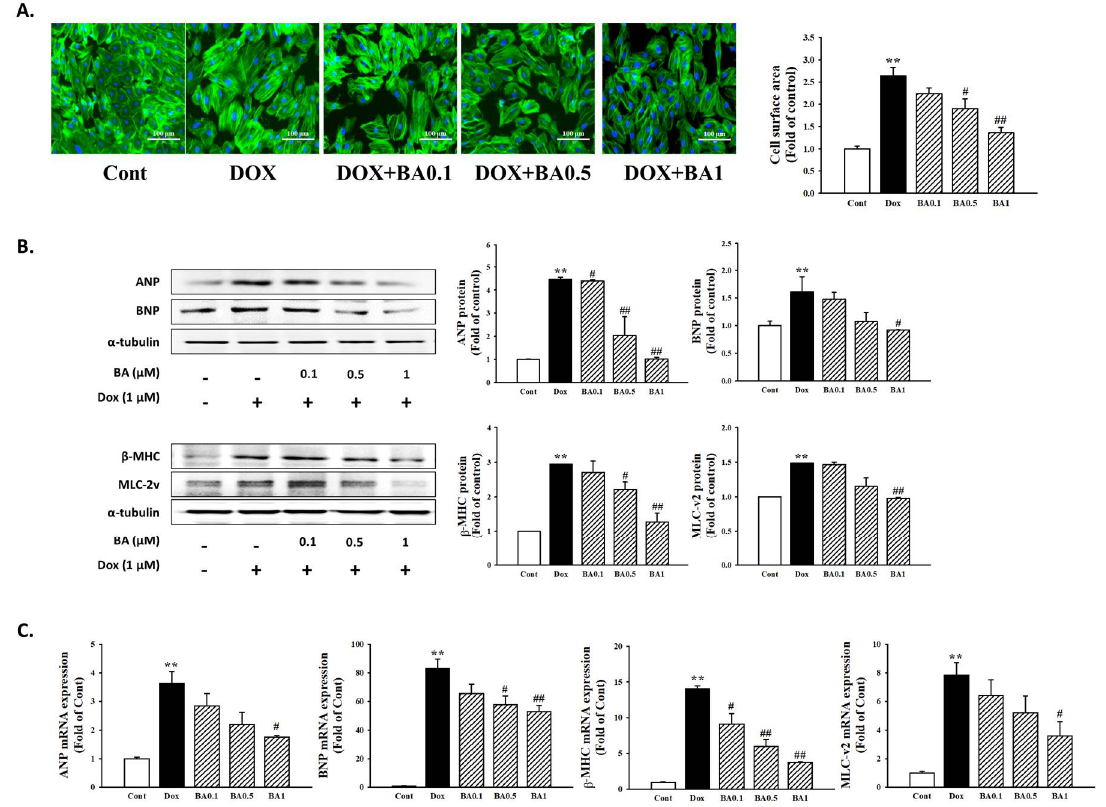
Figure 2. The effects of BA on DOX-induced cardiac hypertrophy. ( A ) The effects of BA on cell surface area size. The cell surface area was measured using anti-F-actin staining (green) under fluorescence microscopy. The nucleus was stained with DAPI (blue) (Scale bar = 100 µ m). ( B , C ) Effect of BA on cardiomyocyte hypertrophy markers in DOX-treated H9c2 cells. The relative expression of ANP, BNP, β -MHC, and MLC-2v was determined using Western blot analysis and RT-qPCR assay. All experiments were performed at least three times. Data represent mean ± SD. ** p < 0.01, vs. control; # p < 0.05, ## p < 0.01 vs. DOX-treated